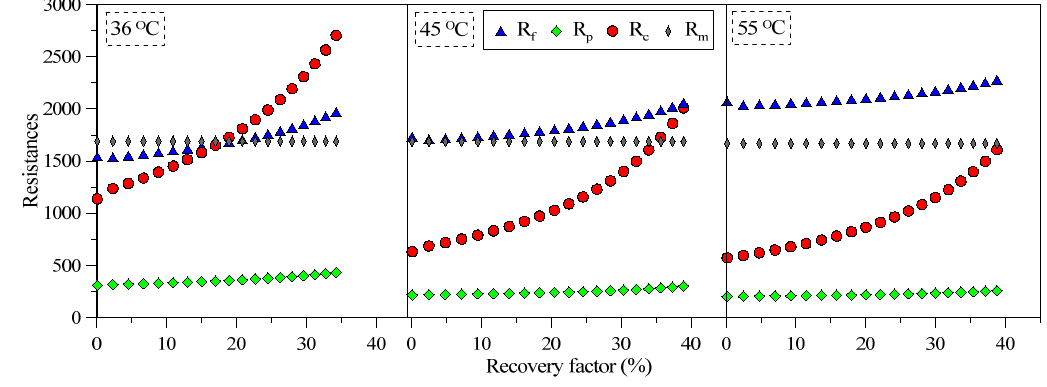
Figure 3. Various resistances to mass transfer at different temperatures as function of solution